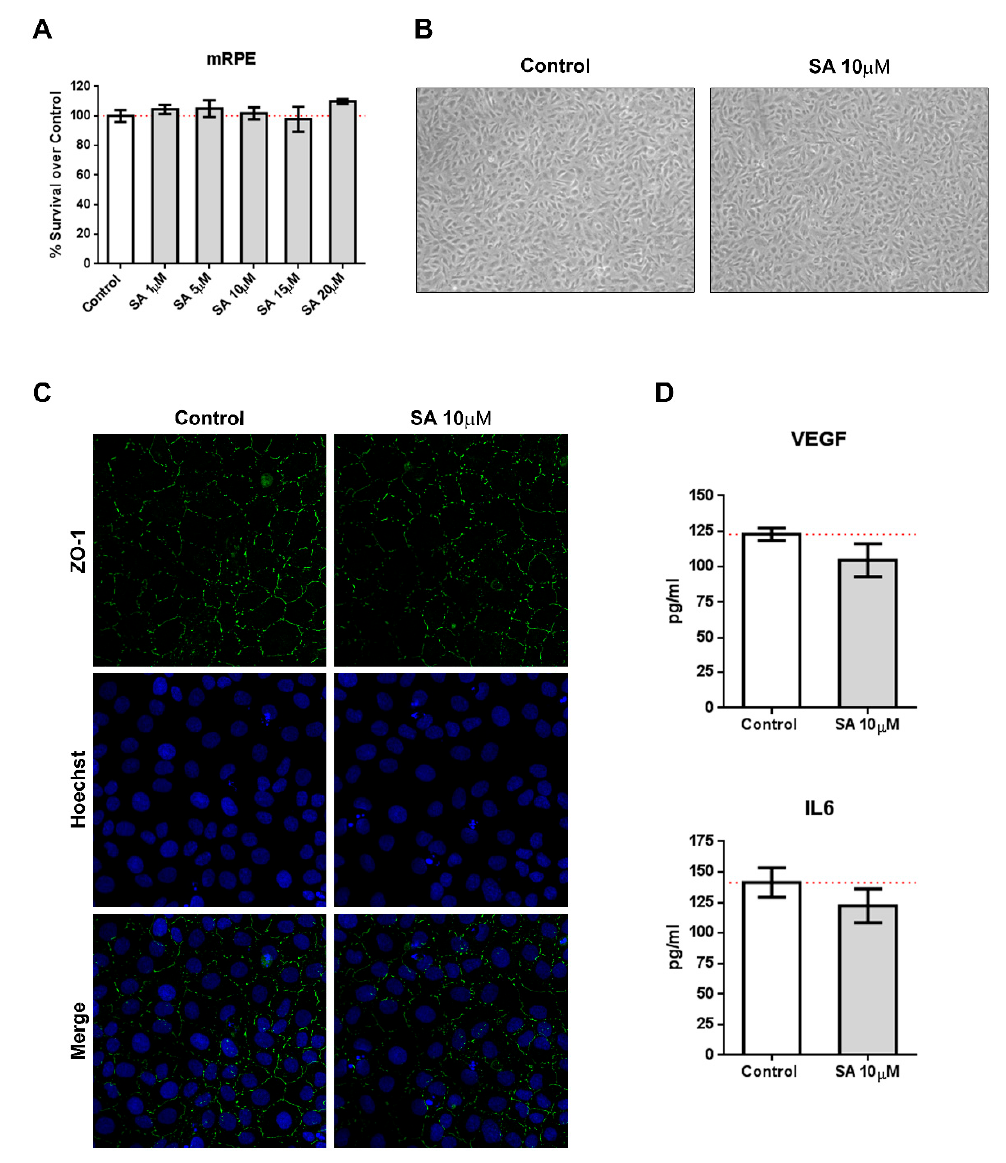
Figure 1. Sterculic acid (SA) does not show toxic e ff ects in retinal cells. ( A ) Sterculic acid cytotoxicity (1–20 µ M) in mRPE cells was measured by the MTS method. Data are presented as mean ± SEM of 12-well plates of four di ff erent experiments. The red dashed line is a guidance mark of 100% of viability in control cells. ( B ) Representative brightfield images of cell morphology in the control and 10 µ M SA-treated mRPE cells after 24 h. ( C ) ZO-1 (green) distribution in cell-cell contacts of control and 10 µ M SA-treated mRPE cells for 24 h. Cell nucleus (blue) was stained with the Hoechst DNA-marker. ( D ) VEFG an IL6 release was measured by ELISA in the conditioned media of the mRPE cells 24 h after treatment with or without 10 µ M SA. The figures show mean ± SEM of at least three di ff erent experiments.